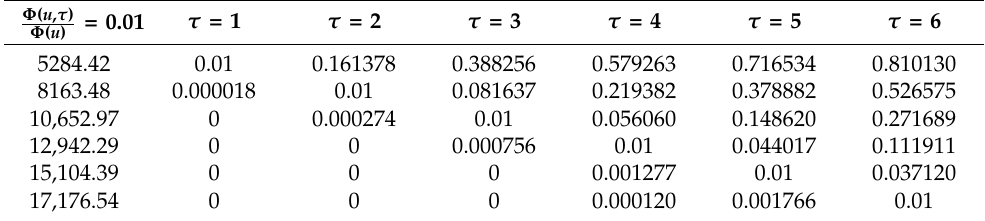
Table 9. Optimal reinsurance parameters q = 0.5815, α / S = 0.3472 and an ensured surplus of 7500. Φ ( u , τ ) Φ ( u ) = 0.01